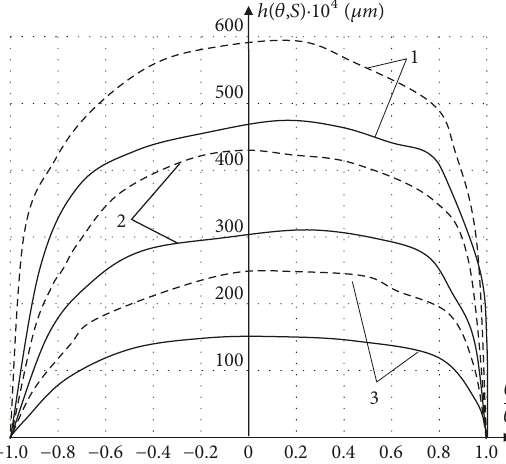
Figure 7: Abrasive wear of the hub surface for one stroke of the